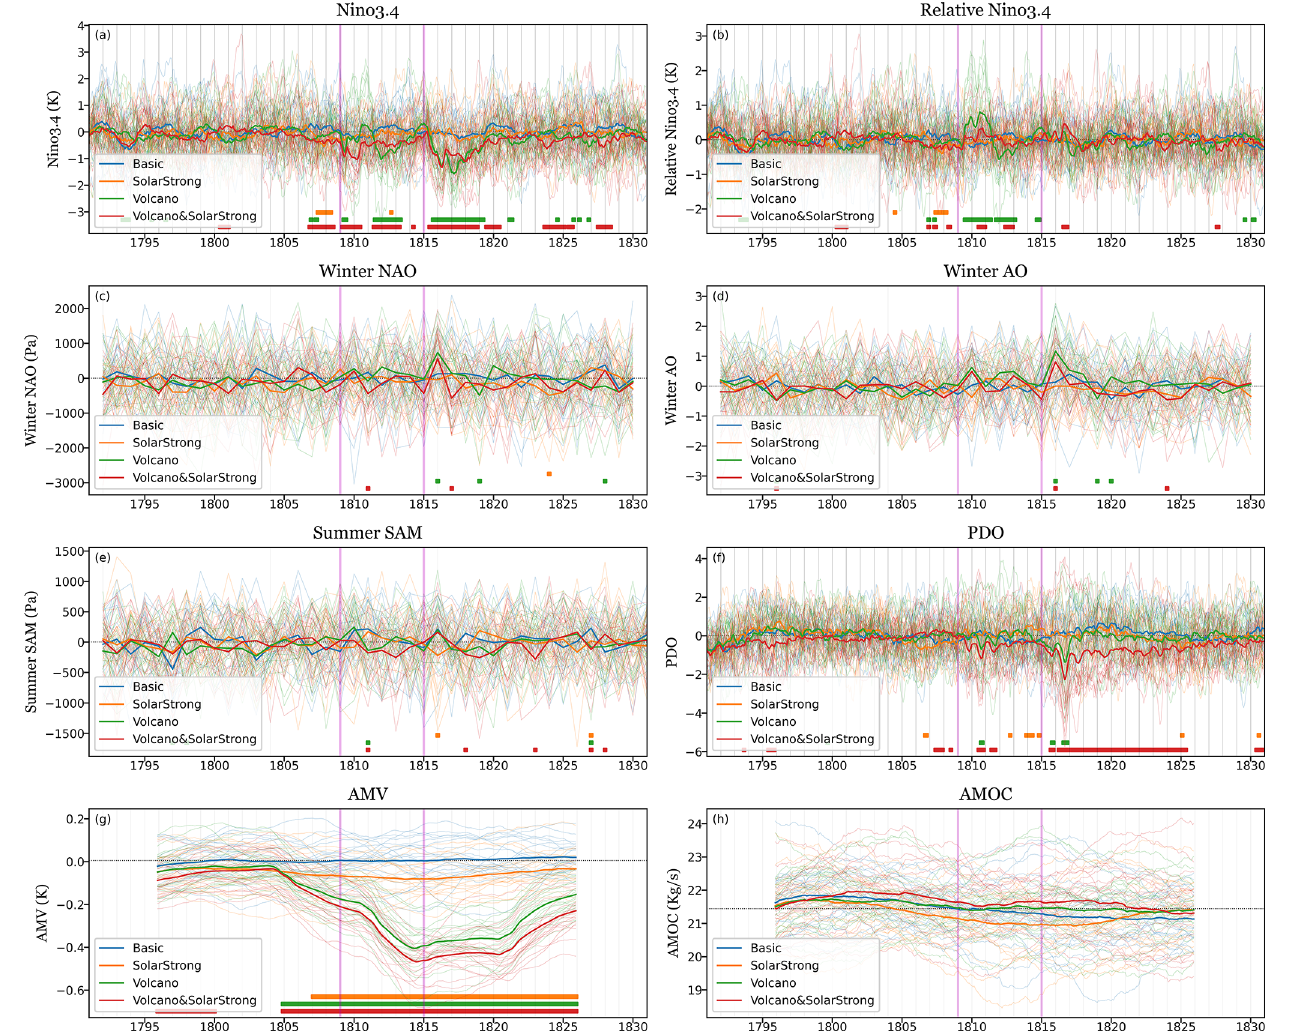
Figure 10. As in Fig. 2, but for (a) the Niño3.4 index (K), (b) relative Niño3.4 index (K), (c) winter NAO index (Pa), (d) winter AO index, (e) summer SAM index (Pa), (f) PDO index, (g) AMV index (K), and (h) AMOC index (kgs − 1 ). The Basic experiment is in blue, SolarStrong is in orange, Volcano is in green, and Volcano&SolarStrong is in